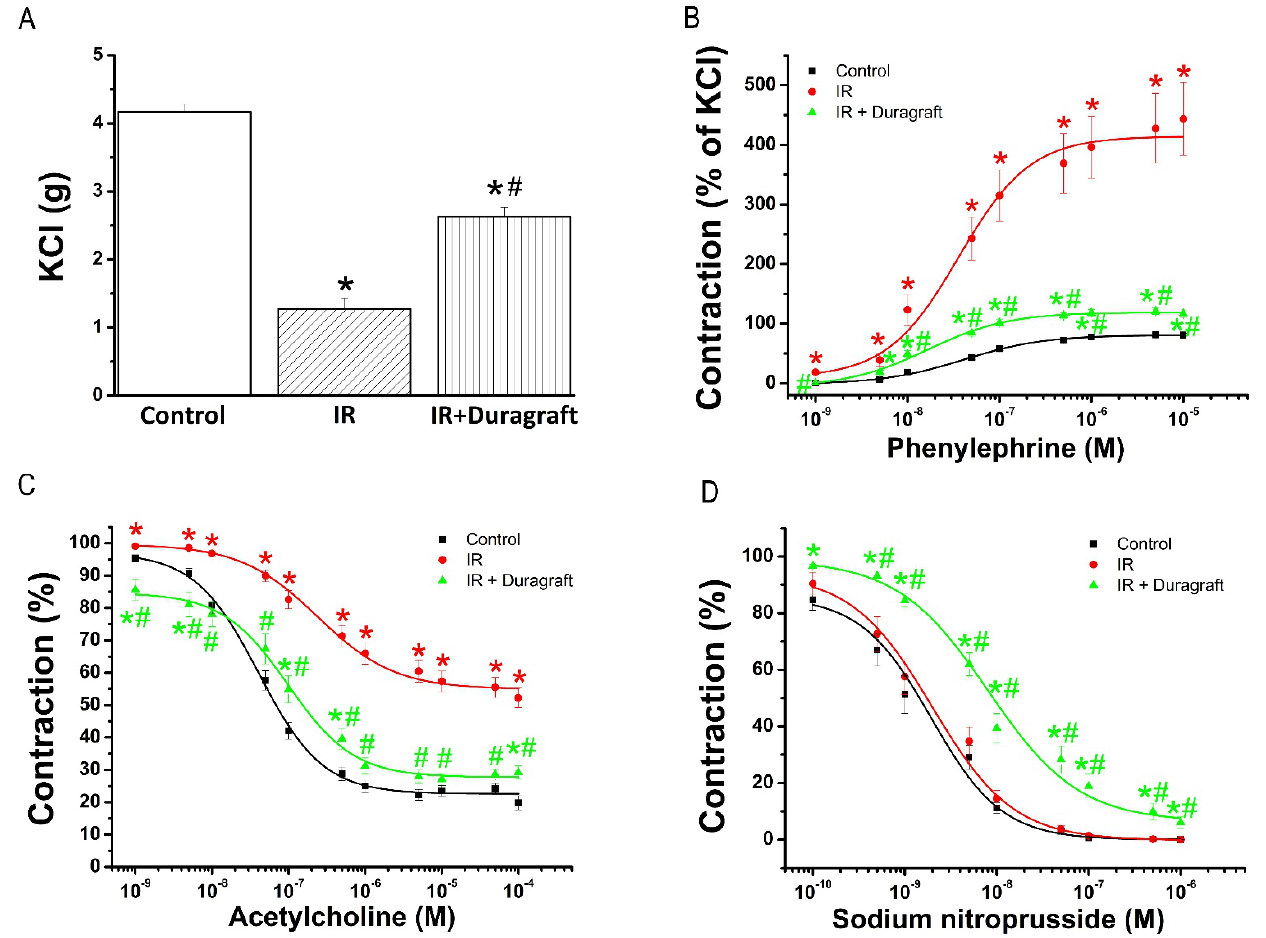
Figure 1. Effect of DuraGraft® on vascular contractile and relaxation responses after ischemia/reperfusion (IR) injury. Contractile responses ( A ) to high K + -induced depolarization and ( B ) phenylephrine (expressed as percentage of the maximum contraction induced by 80 mM potassium chloride (KCl), and ( C ) acetylcholine-induced endothelium-dependent- and ( D ) sodium nitroprusside-induced endothelium-independent vasorelaxation of isolated aortic rings. Results are represented as mean ± SEM. * p < 0.05 versus control; # p < 0.05 versus IR. n = 21 – 36 aortic rings from 7 – 9 rats/group.